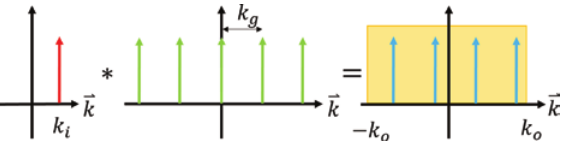
Figure 16: A diagram showing spectral representations of the illumination wave (left), the periodic metasurface (center), and the reradiated wave (right). The arrows represent the presence of a plane wave/diffraction order but do not imply uniform amplitude or phase across the diffraction